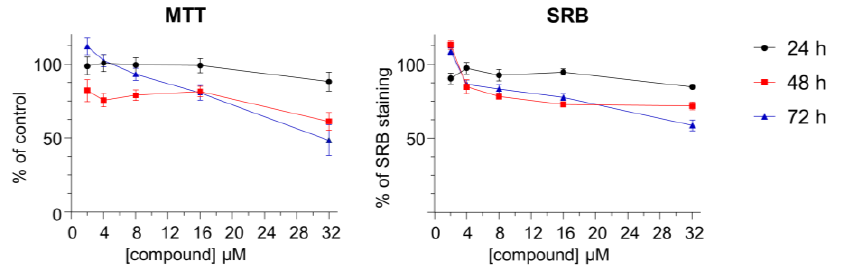
Figure 3. Dose–response curves for [Pt 2 Put 2 (NH 3 ) 4 ] 4+ against the BEAS-2B human lung non-cancer cell line, at 24, 48 and 72 h incubation times. Data are expressed as mean ± SEM, n = 4. Table 1. Half maximal inhibitory concentration (IC 50 , µM) of cisplatin and [Pt 2 Put 2 (NH 3 ) 4 ] 4+ against the A549 human lung cancer and the BEAS-2B human lung non-cancer cell lines, at 24, 48 and 72 h incubation times.